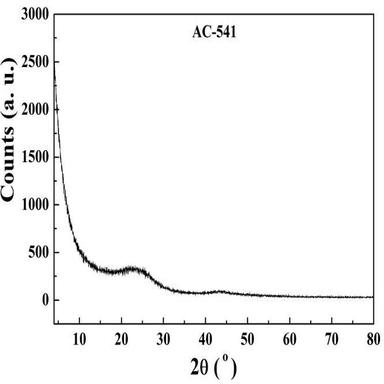
Nitrogen adsorption and desorption isotherm patterns of TiO2-541, TiO2-AC15%-541, and AC-541.